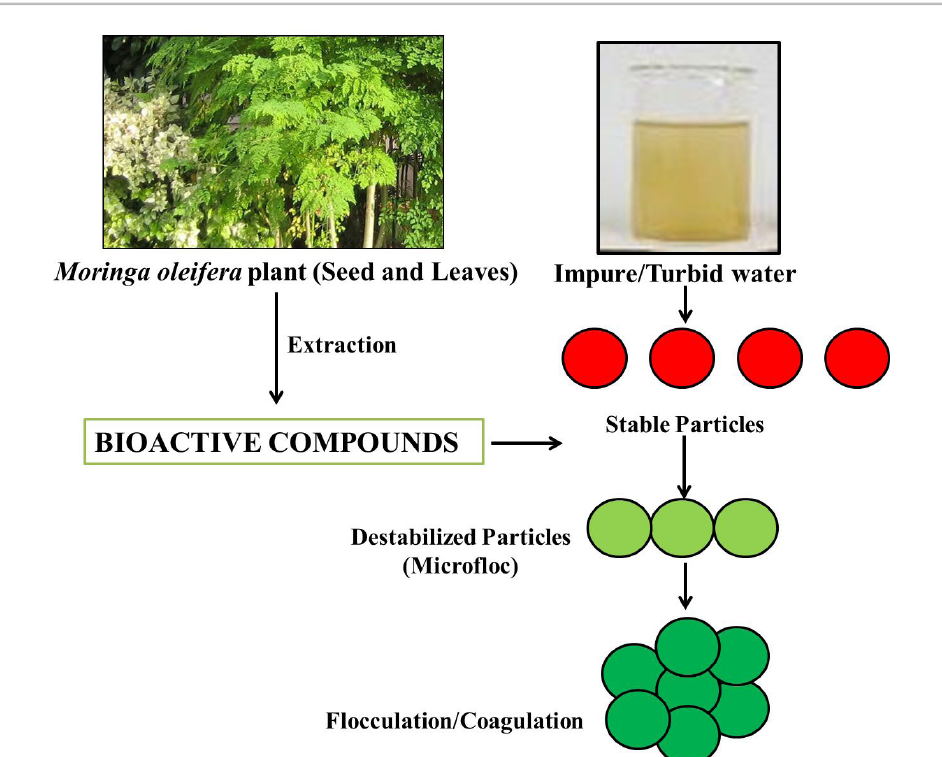
FIGURE 3 - Mechanism behind the flocculation process by Moringa oleifera